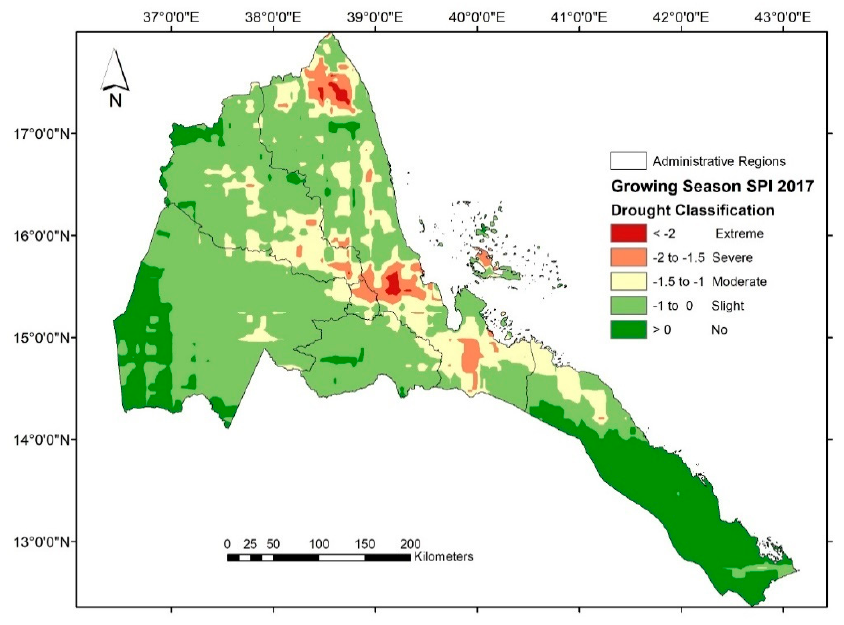
Figure 12. SPI-4 drought classification for the main growing season of 2017.